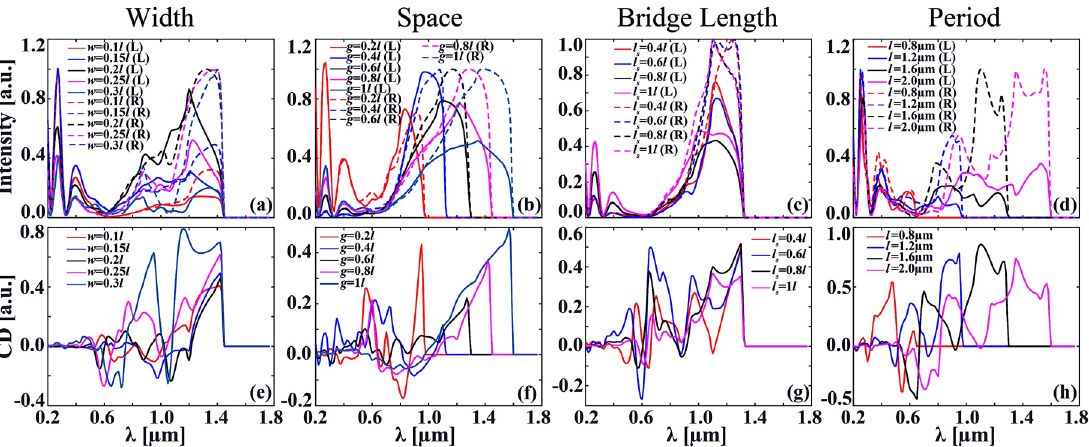
Figure 8: The model-agnostic data enhancement (MADE) model predicted chiroptical response spectra in S1 chiral metamaterials with different chiral